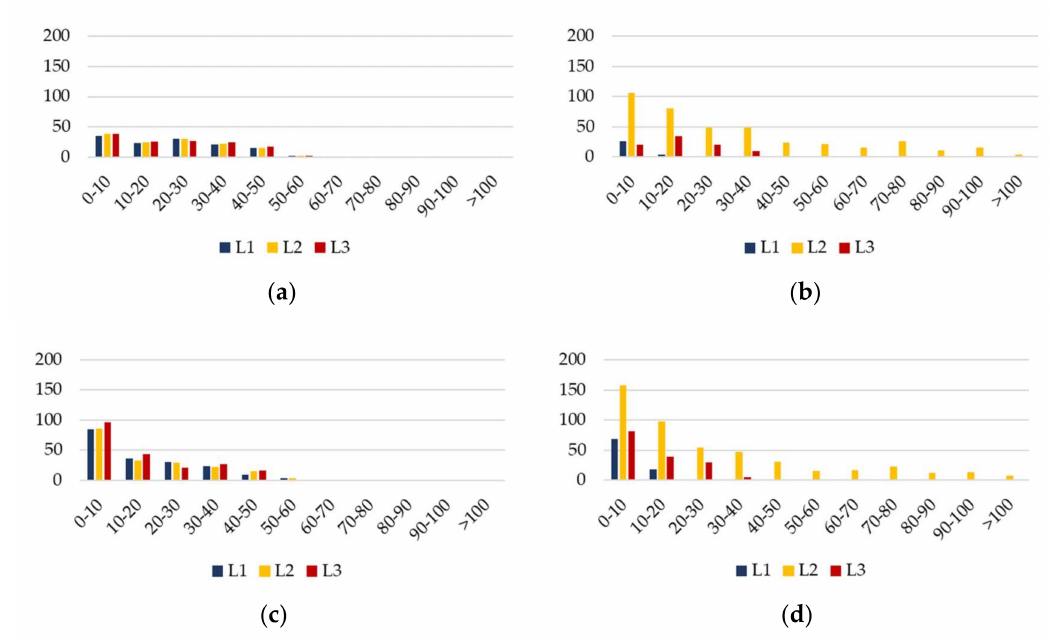
Figure 21. The number of hours during the year in which the rated current of the transformer (branch R 0 –R 1 ) is exceeded by a value within the defined ranges (% of the rated current): ( a ) V3, ( b ) V5, ( c ) V8, and ( d ) V10.